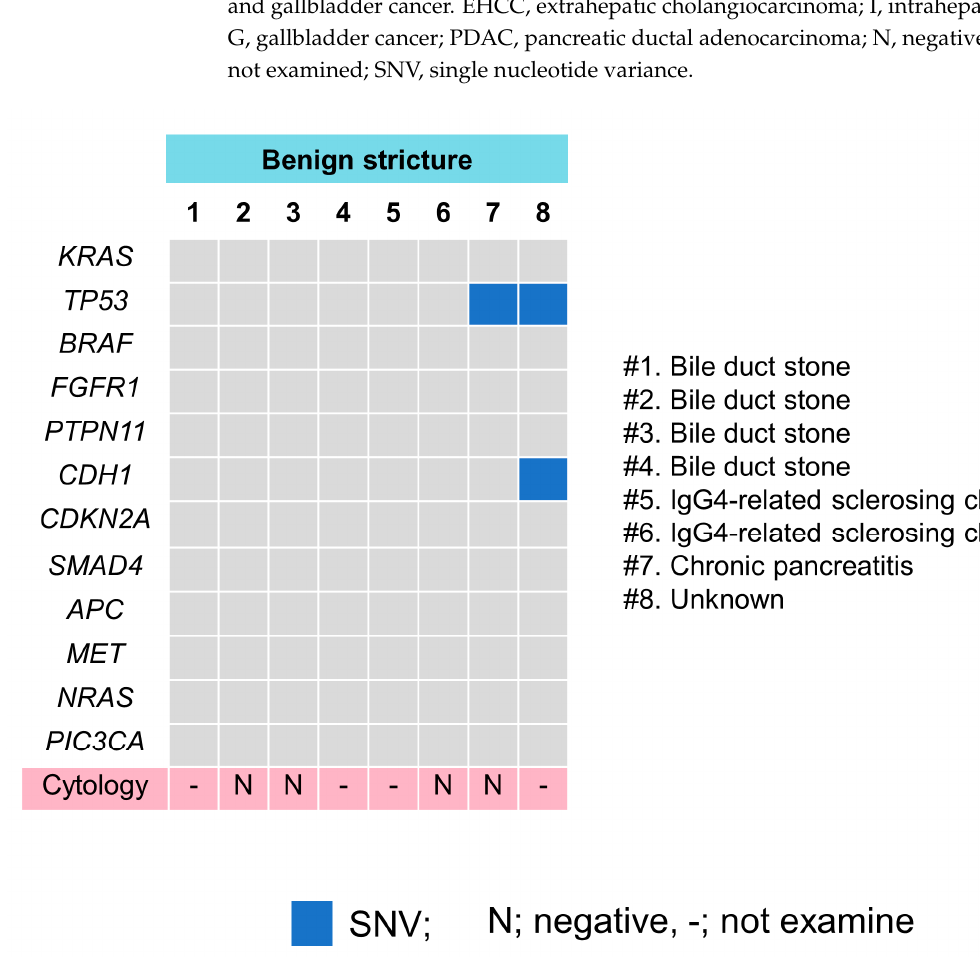
Figure 5. Pathogenic gene alteration profile in bile cfDNA of the patients with benign biliary stricture. TP53 and CDH1 mutations were detected in two patients. (#) means case number.